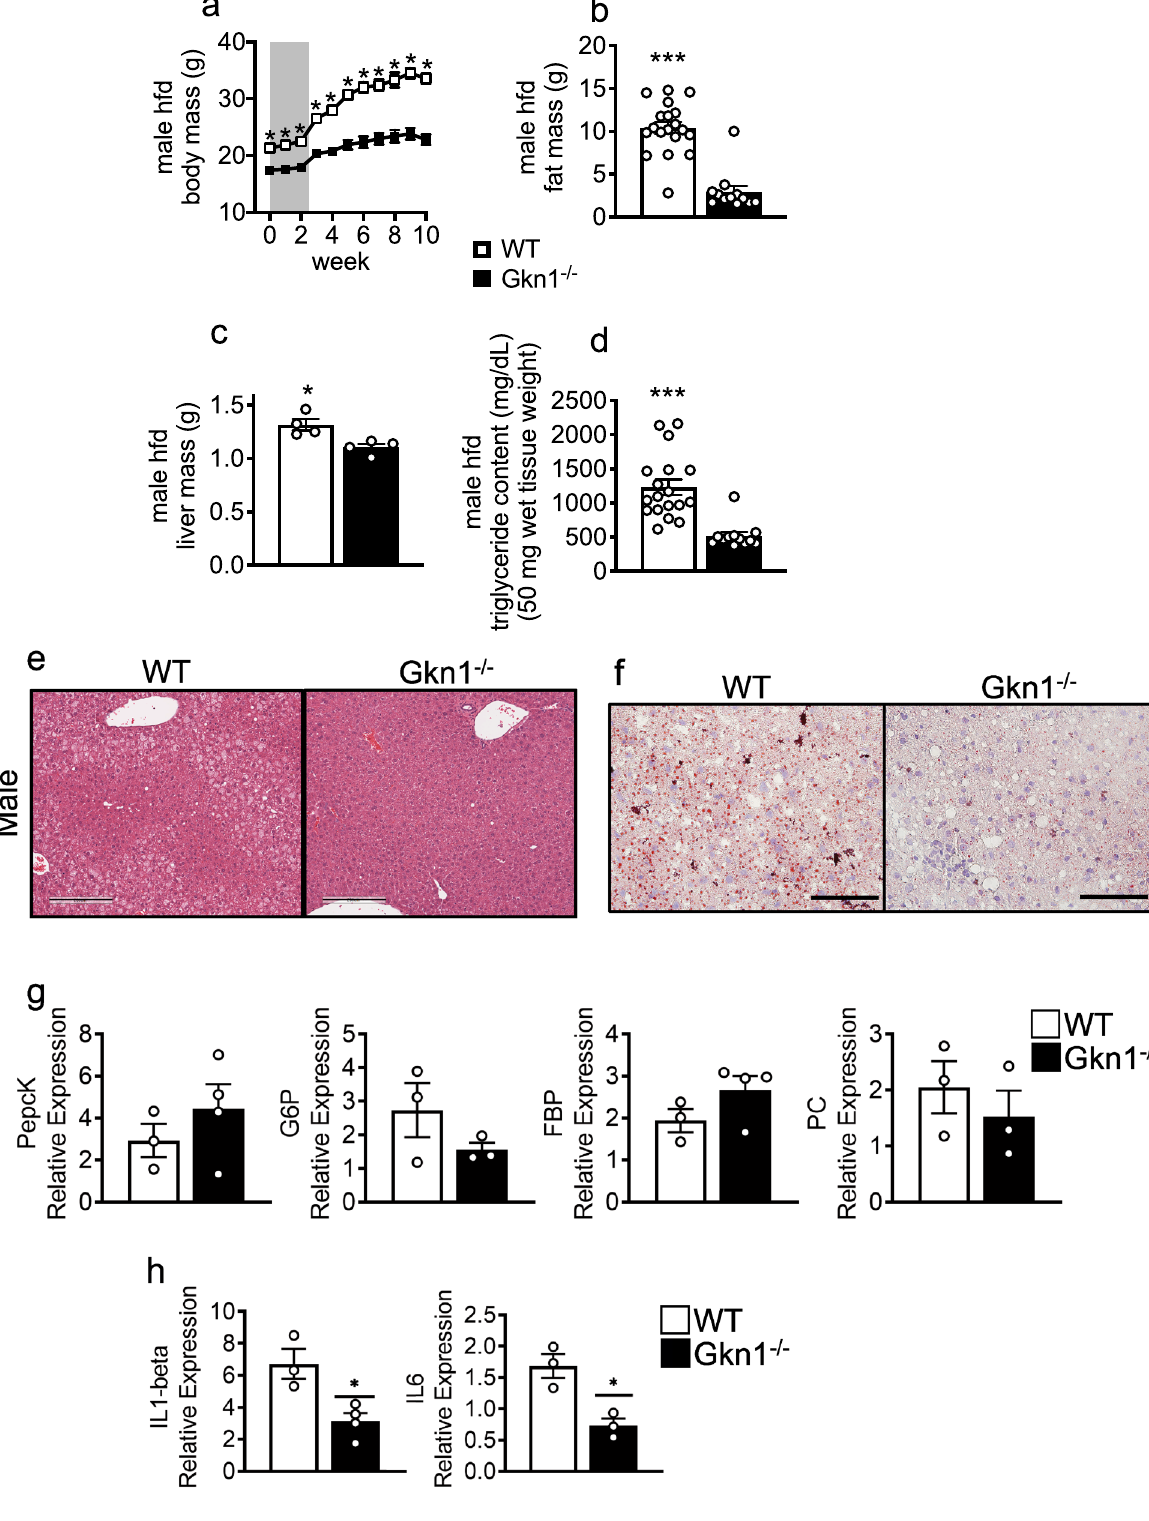
Figure 4. GKN1 regulates fat accumulation in response to high fat diet. Male WT and GKN1 −/− mice were individually caged and then switched from NCD to HFD and monitored for 8 weeks for ( a ) body weight and ( b ) fat mass (by qMRI) (n = 12–15). Livers were excised and assessed for ( c ) total weight, ( d ) triglyceride content and ( e ) presence of steatosis by H&E histology or presence of lipid by ( f ) staining with oil red O (scale bar is 200 μM). Expression levels of gene for ( g ) gluconeogenesis (PepcK, G6P, FBP, PC) or ( h ) inflammation (IL1b, IL6) were assessed in liver tissue from HFD treated mice. (n = 3–4) * p < 0.05, ** p < 0.01, *** p <